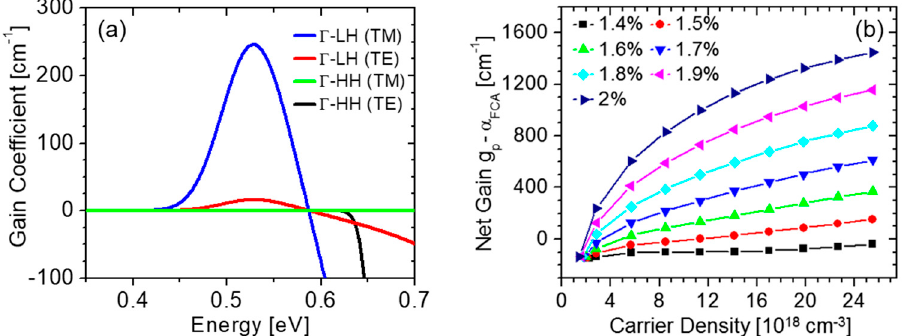
Figure 2. Optical gain properties of tensilely strained Ge. ( a ) Calculated TE and TM optical-gain spectra due to c Γ -LH and c Γ -HH transitions in Ge under 1.78-% biaxial tensile strain, in the presence of a density of injected carriers of 3.9 × 10 18 cm − 3 . These values of strain and carrier density correspond to the experimental data shown in Figure 4b below. Reproduced with permission from [20]. John Wiley and Sons, 2012; ( b ) Peak gain coefficient of undoped Ge (including the effect of free-carrier absorption) plotted as a function of injected carrier density for different strain values. Reproduced with permission from [28]. AIP Publishing LLC, 2016.